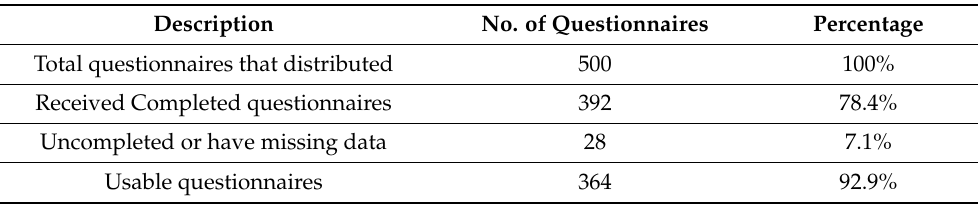
Table 1. Response rate of the data